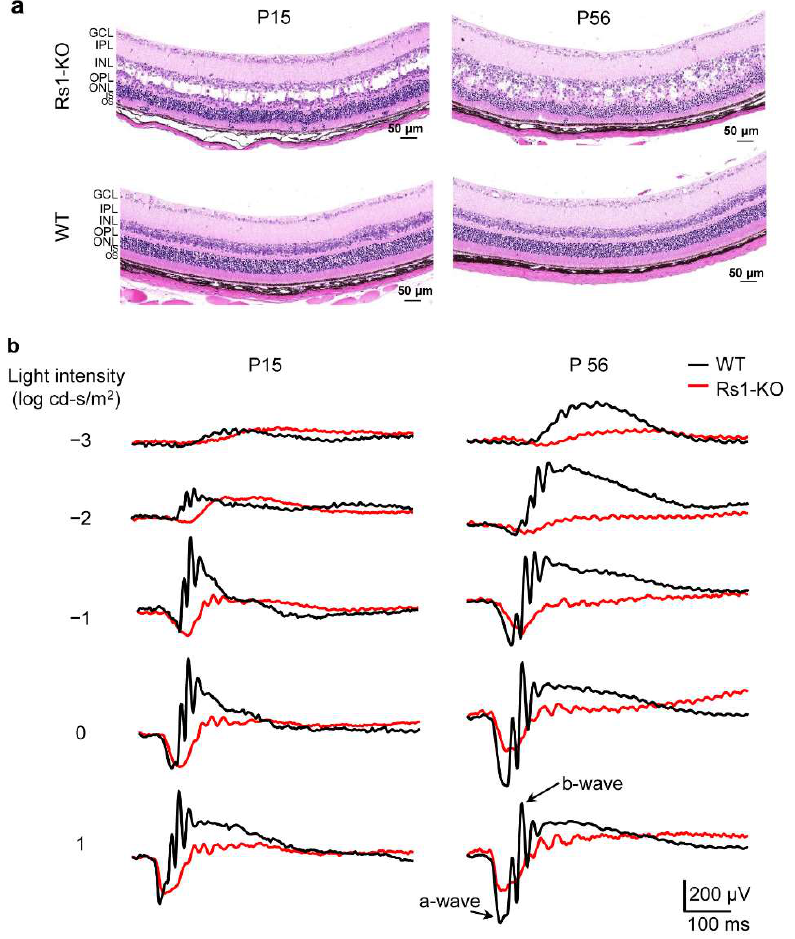
Figure 1. Morphological and functional evaluation of RS1-KO retina. ( a ) RS1-KO and age-matched WT mouse retina sections with HE staining. ( b ) Conventional ERG amplitudes elicited with a series of light intensities in RS1-KO mice and age-matched WT mice. P, postal day; KO, knock out; WT, wild type; HE, hematoxylin–eosin; ERG, electroretinogram; GCL, ganglion cell layer; IPL, inner plexiform layer; INL, inner nuclear layer; ONL, outer nuclear layer; OPL, outer plexiform layer; OS, outer segment; IS, inner segment.